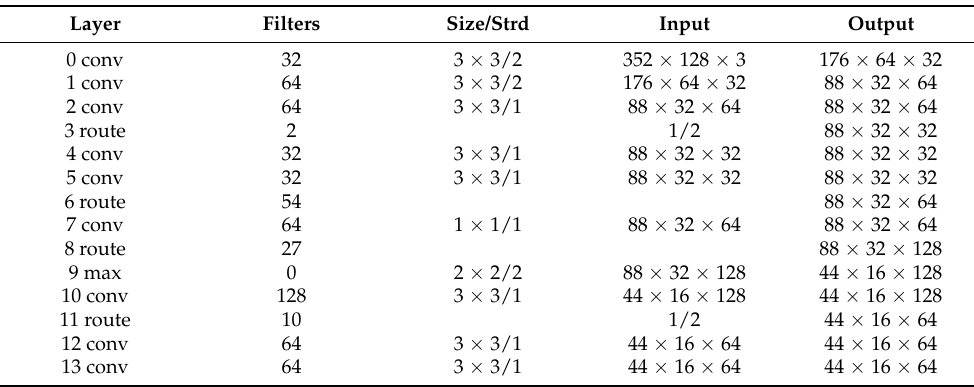
Table 4. LP recognition model